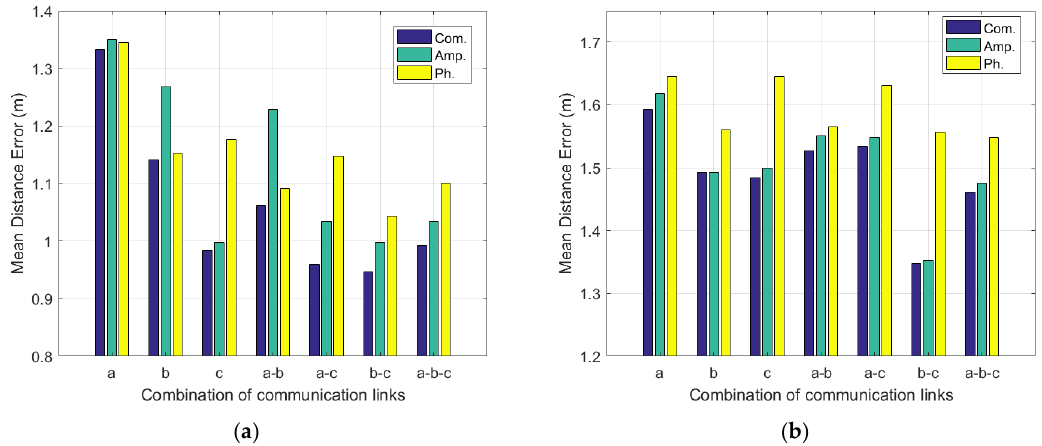
Figure 15. Mean distance errors under different situations in ( a ) the corridor and ( b ) laboratory.